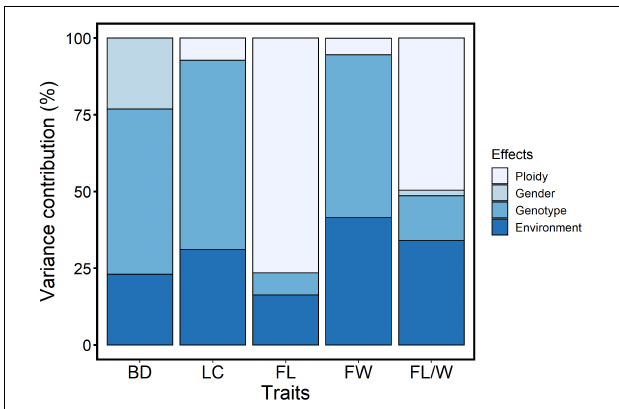
FIGURE 5 | Disaggregation of ploidy, gender, and genotype effects on woody and fiber properties based on variance contributions. BD, Basic density; LC, Lignin content; FL, Fiber length; FW, Fiber width; FL/W, Fiber length/width.